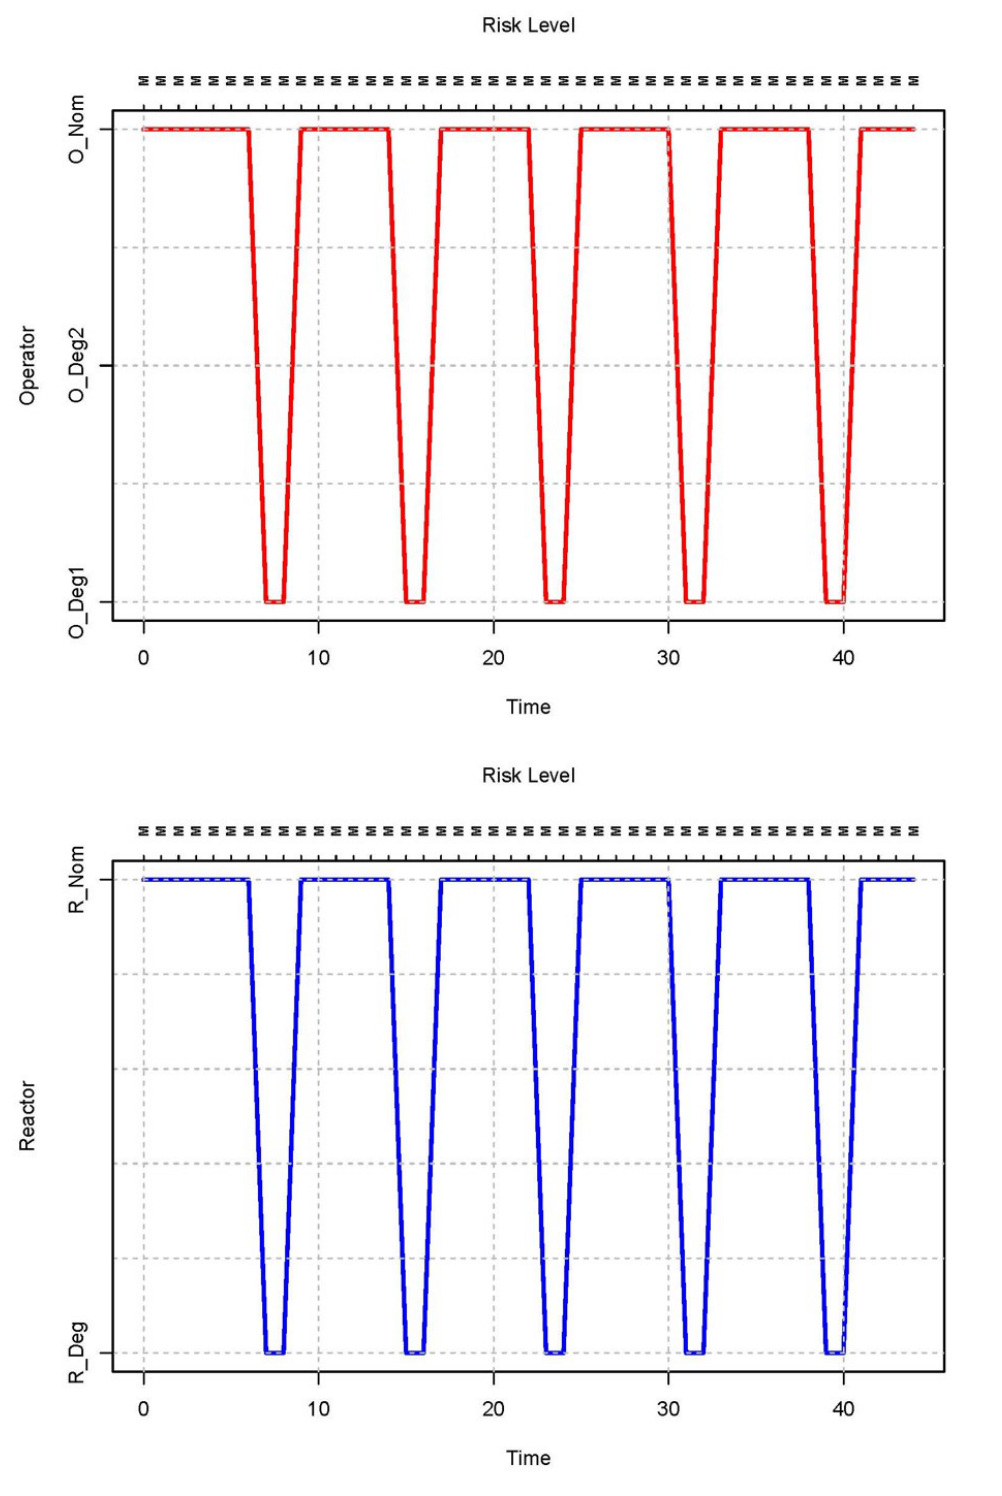
Figure 17. Agent’s behavioral modes with the related Risk Level during simulation